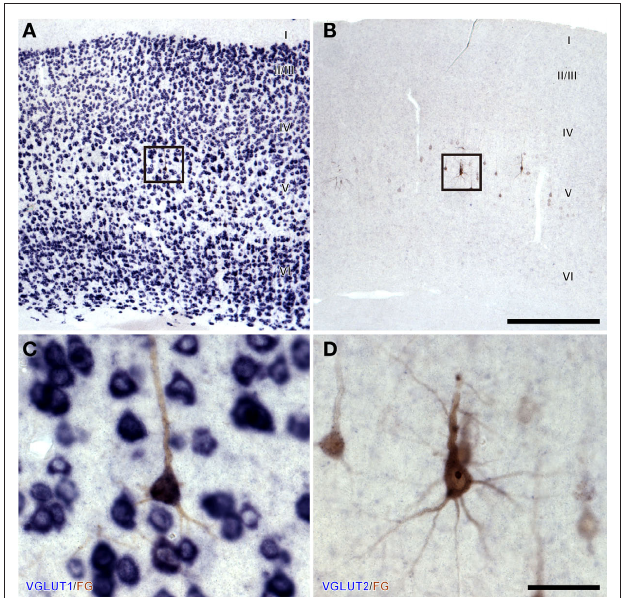
Figure 4 | Corticofugal neurons in layer 5 (V) express only VgLuT1. Brightfield ISH for VGLUT1 (A,C) or VGLUT2 (B,D) combined with immunohistochemistry for FG showed that retrogradely labeled pyramidal neurons express VGLUT1 but not VGLUT2. (C,D) Are the higher magnification of boxes in (A,B ), respectively. Scale bars: 500 μm (A,B) , and 50 μm (C,D)